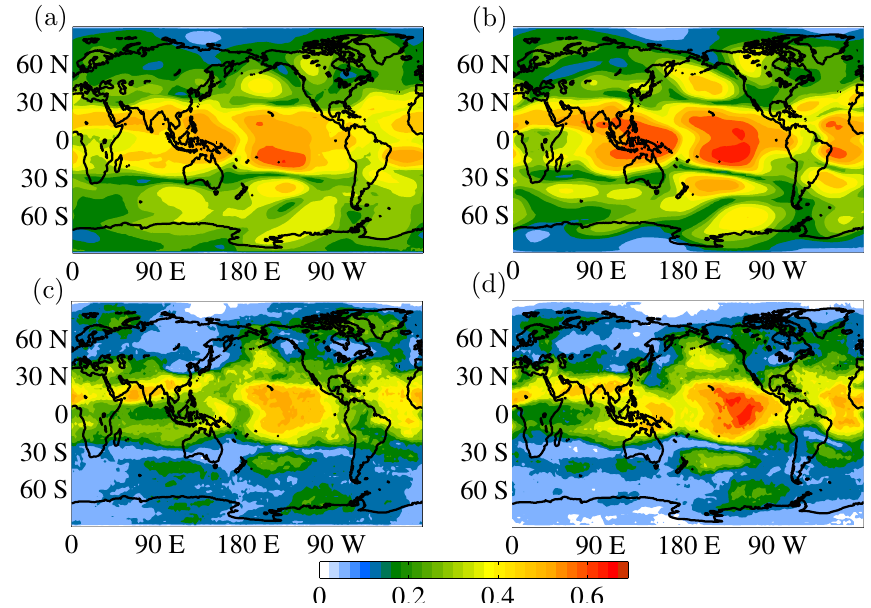
Figure 2. AWC maps of the 200mb eddy geopotential height field with the graph construction methodology applied to the 20th Century Reanalysis data from NOAA. Statistical similarity measures and periods taken: (a) PC (1901–1955), (b) PC (1955–2009), (c) MI with classical histograms (1901–1955) and (d) MI with classical histograms